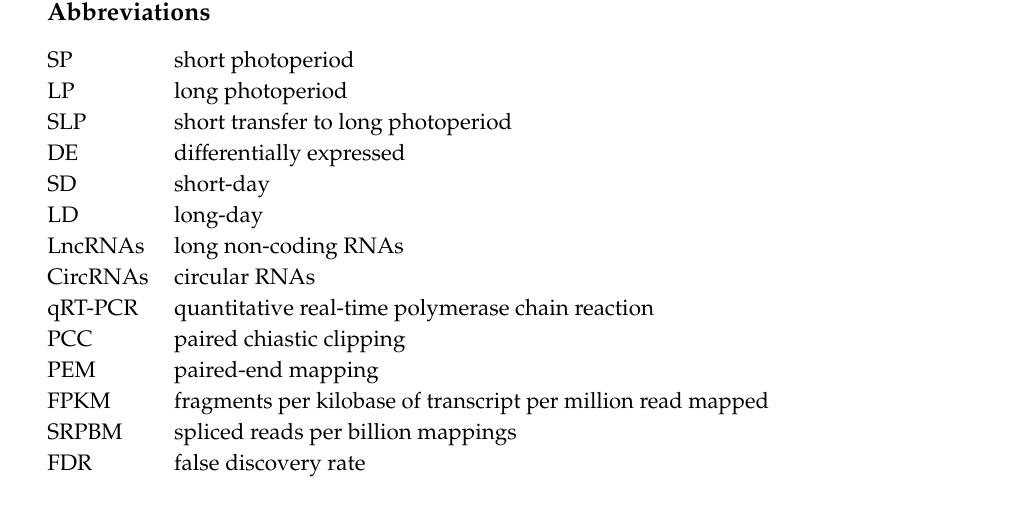
Table S25: KEGG enrichment analysis of the sourced genes of circRNAs di ff erentially expressed between SP and SLP, Table S26: KEGG enrichment analyses of mRNAs between LP and SLP, Table S27: KEGG enrichment analysis of the targeted genes of di ff erentially expressed lncRNAs between LP and SLP, Table S28: KEGG enrichment analysis of the sourced genes of circRNAs di ff erentially expressed between LP and SLP, Table S29: The network that di ff erentially expressed lncRNAs and their targeted di ff erentially expressed mRNAs between SP and LP, Table S30: The network that di ff erentially expressed lncRNAs and their targeted di ff erentially expressed mRNAs between SP and SLP, Table S31: The network that di ff erentially expressed lncRNAs and their targeted di ff erentially expressed mRNAs between LP and